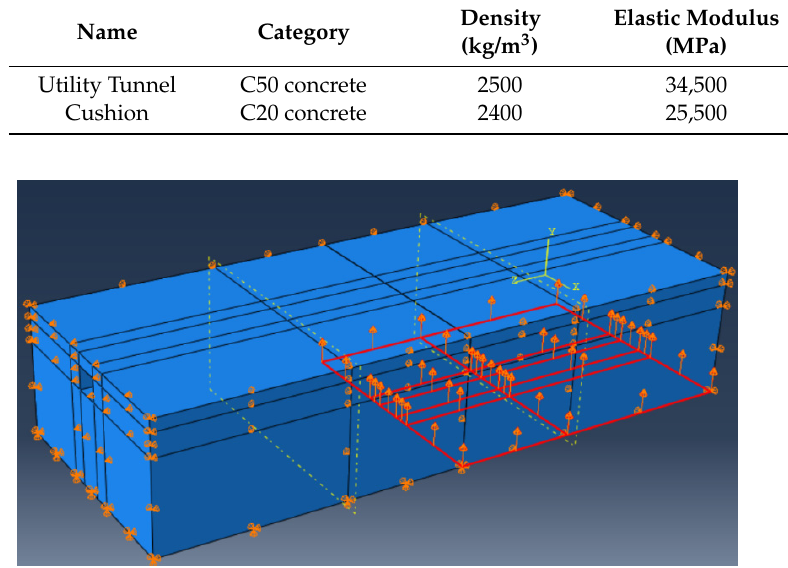
Figure 3. Boundary condition setting.